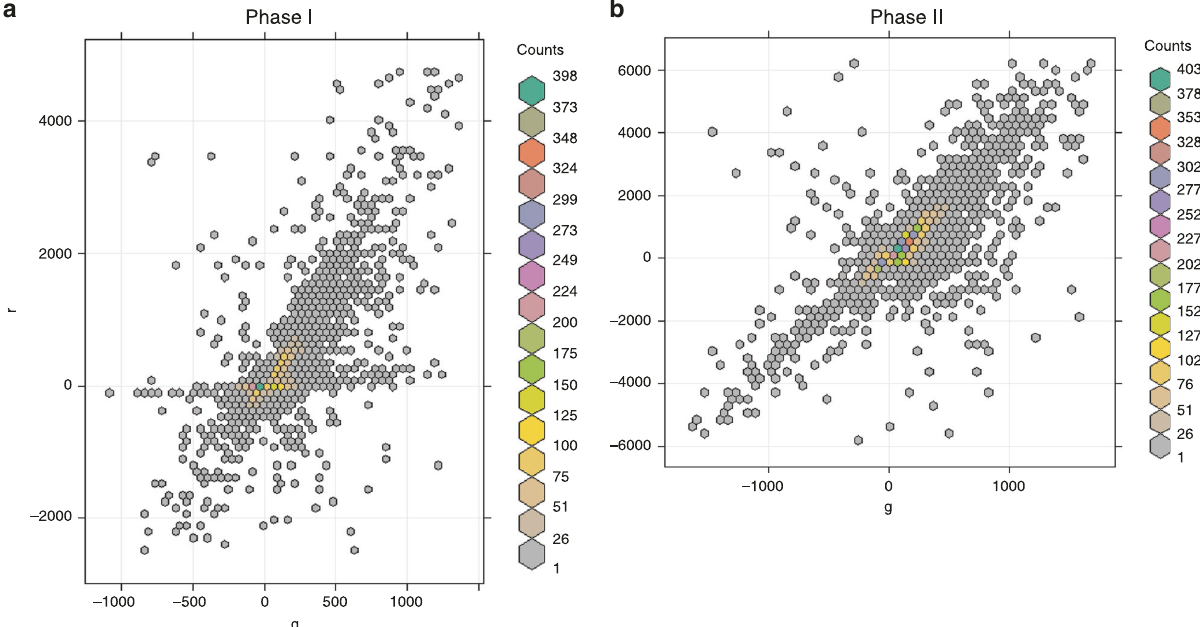
Fig. 3 Heat maps of fi rms ’ trading performance based on the fi rm-level trading data. a , b The fi rms ’ trading performance in Phase I and Phase II, respectively. The fi rms are plotted on the g – r coordinate system using their processed abatements for trading g ’ and trading pro fi ts r ’ as coordinates. The different colors of the grids denote different volumes of the participating fi rms within the corresponding